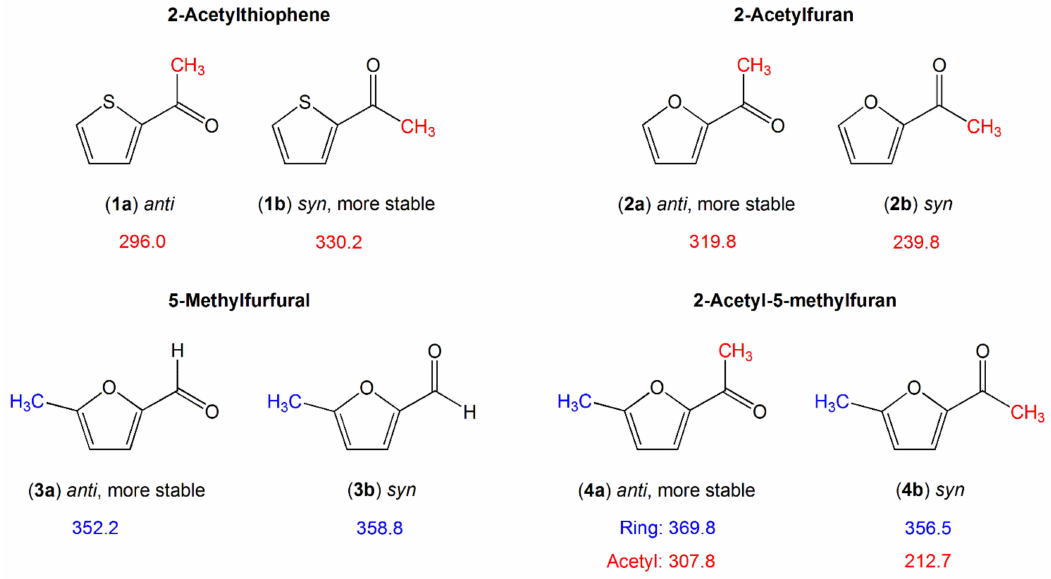
Figure 4. Barriers to methyl internal rotation in furan and thiophene derivatives with a carbonyl- group-containing substituent (in cm − 1 ). ( 1 ) 2-Acetylthiophene [132], ( 2 ) 2-acetylfuran [133], ( 3 ) 5-methyl furfural [134], ( 4 ) 2-acetyl-5-methylfurfural